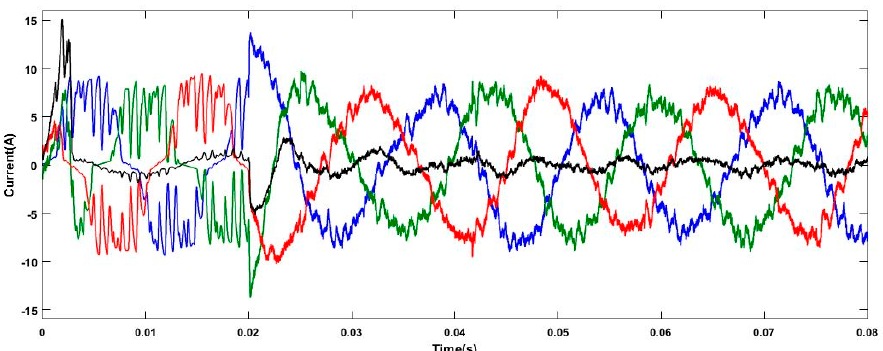
Figure 8. Compensation result with the sliding discrete Fourier transform (DFT) for case 1. Energies 2019 , 12 , x FOR PEER REVIEW